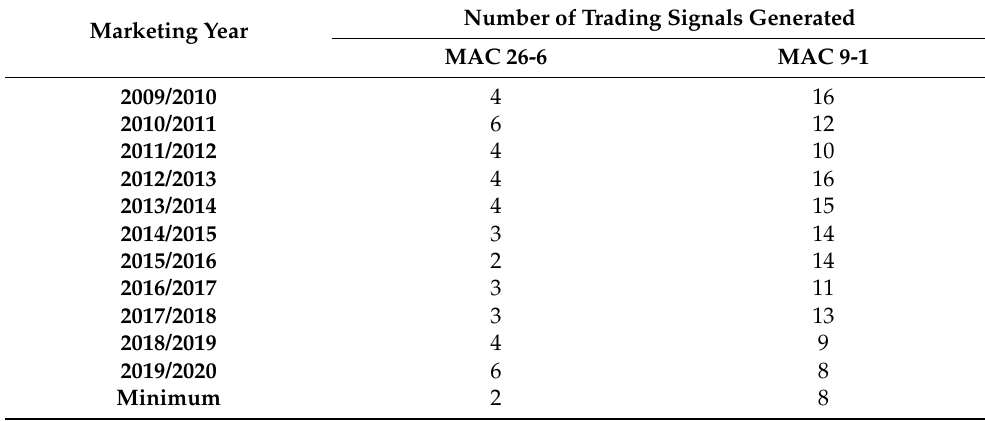
Table 2. Trading frequency for optimal moving average crossover (MAC) pricing strategies for risk-averse and risk-neutral decisions makers over the 11 marketing years.